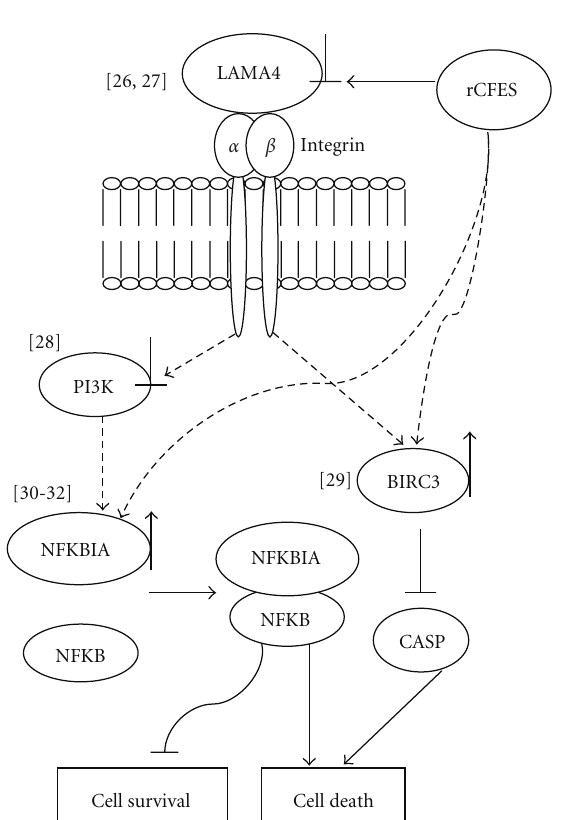
Figure 5: Inferred model for the rCFES-regulated focal adhesion pathway in WI-38 cells. LAMA4, PIK3R3, BIRC3, and NFKBIA identified in this study were included in the rCFES-regulated model in WI-38 cells. Upregulated genes were marked by “ ↑ ” and downregulated genes by “ ⊥ ”. Dotted arrows were links requiring further confirmation and the numbers in “[]” were the supportive previous works listed in the